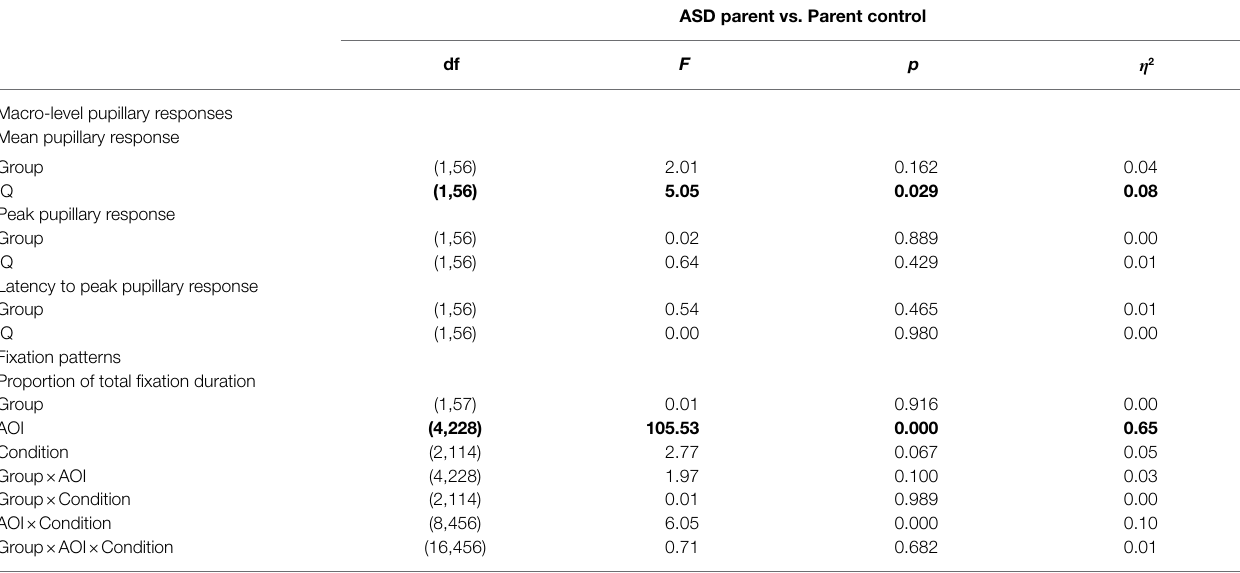
TABLE 3 | ANCOVA results for macro-level pupillary and fixation pattern